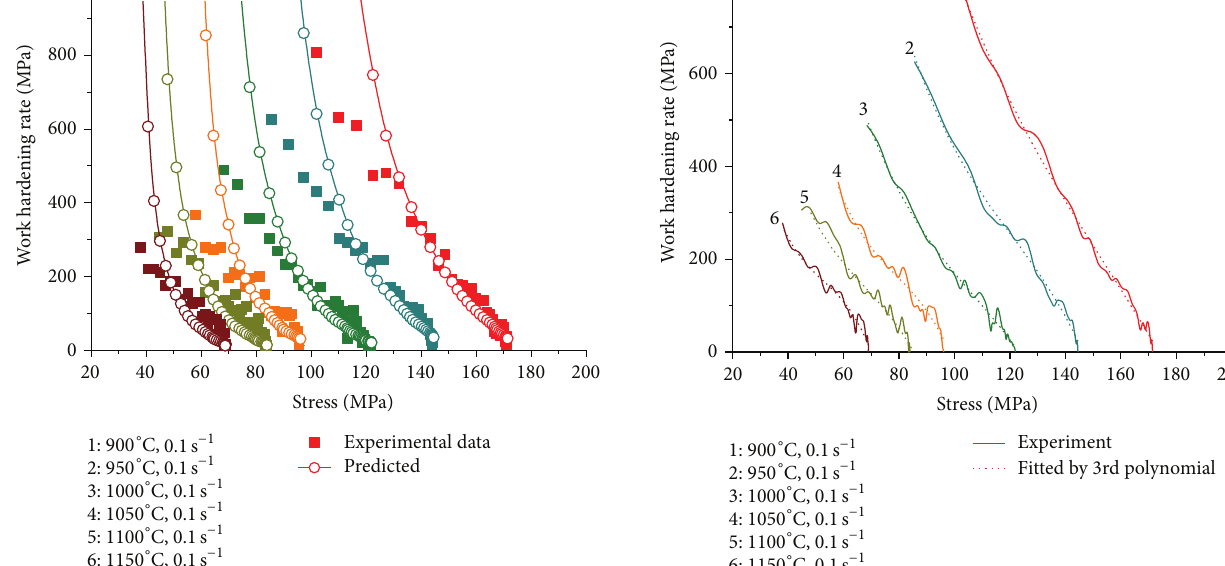
The solution of (19) is as follows (the derivations process